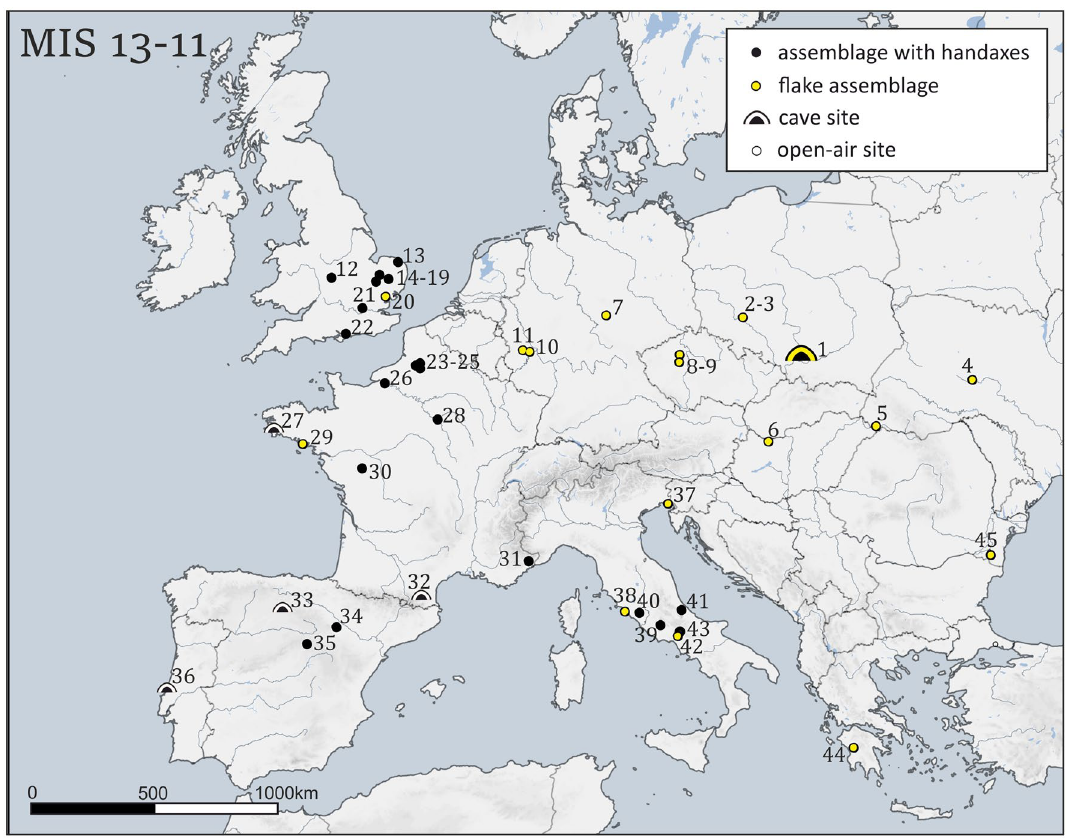
Figure 1. Middle Pleistocene sites dated to MIS 13-11 in Europe. 1. Tunel Wielki Cave; 2. Trzebnica 2; 3. Rusko 33, 36 & 42; 4. Medzhibozh 1; 5. Korolevo; 6. Vértesszölös 2; 7. Bilzingsleben; 8. Račinĕves 9. Karlštejn-Altán; 10. Miesenheim I; 11. Kärlich-Seeufer; 12. Waverly Wood; 13. Happisburgh Site 1; 14. Warren Hill; 15. High Lodge; 16. Beeches Pit; 17. Hoxne;18. Elveden; 19. Barnham; 20. Clacton-on-Sea; 21. Swanscombe; 22. Boxgrove; 23. Cagny-la-Garenne; 24. Ferme de l’Epinette; 25. “Rue de Cagny”; 26. Saint-Pierre-les-Elbeuf; 27. Menez Dregan; 28. La Celle; 29. St. Colomban; 30. La Grande Vallé; 31. Terra Amata; 32. Arago; 33. Atapuerca Galeria; 34. Aridos; 35. Ambrona; 36. Gruta da Aroeira; 37. Visogliano 38. Ficoncella; 39. Fontana Ranuccio; 40. Castel di Guido; 41. Valle Giumentina; 42. Isernia-la-Pineta; 43. Guado San Nicola; 44. Marathousa; 45. Dealul Guran (All site details and references in Supplement Table 1). Map generated using QGIS v. 2.14 (qgis.org), digital elevation model modified from STRM 37 raster data, boundaries and river layers modified from Natural Earth (naturalearthdata.com) vector